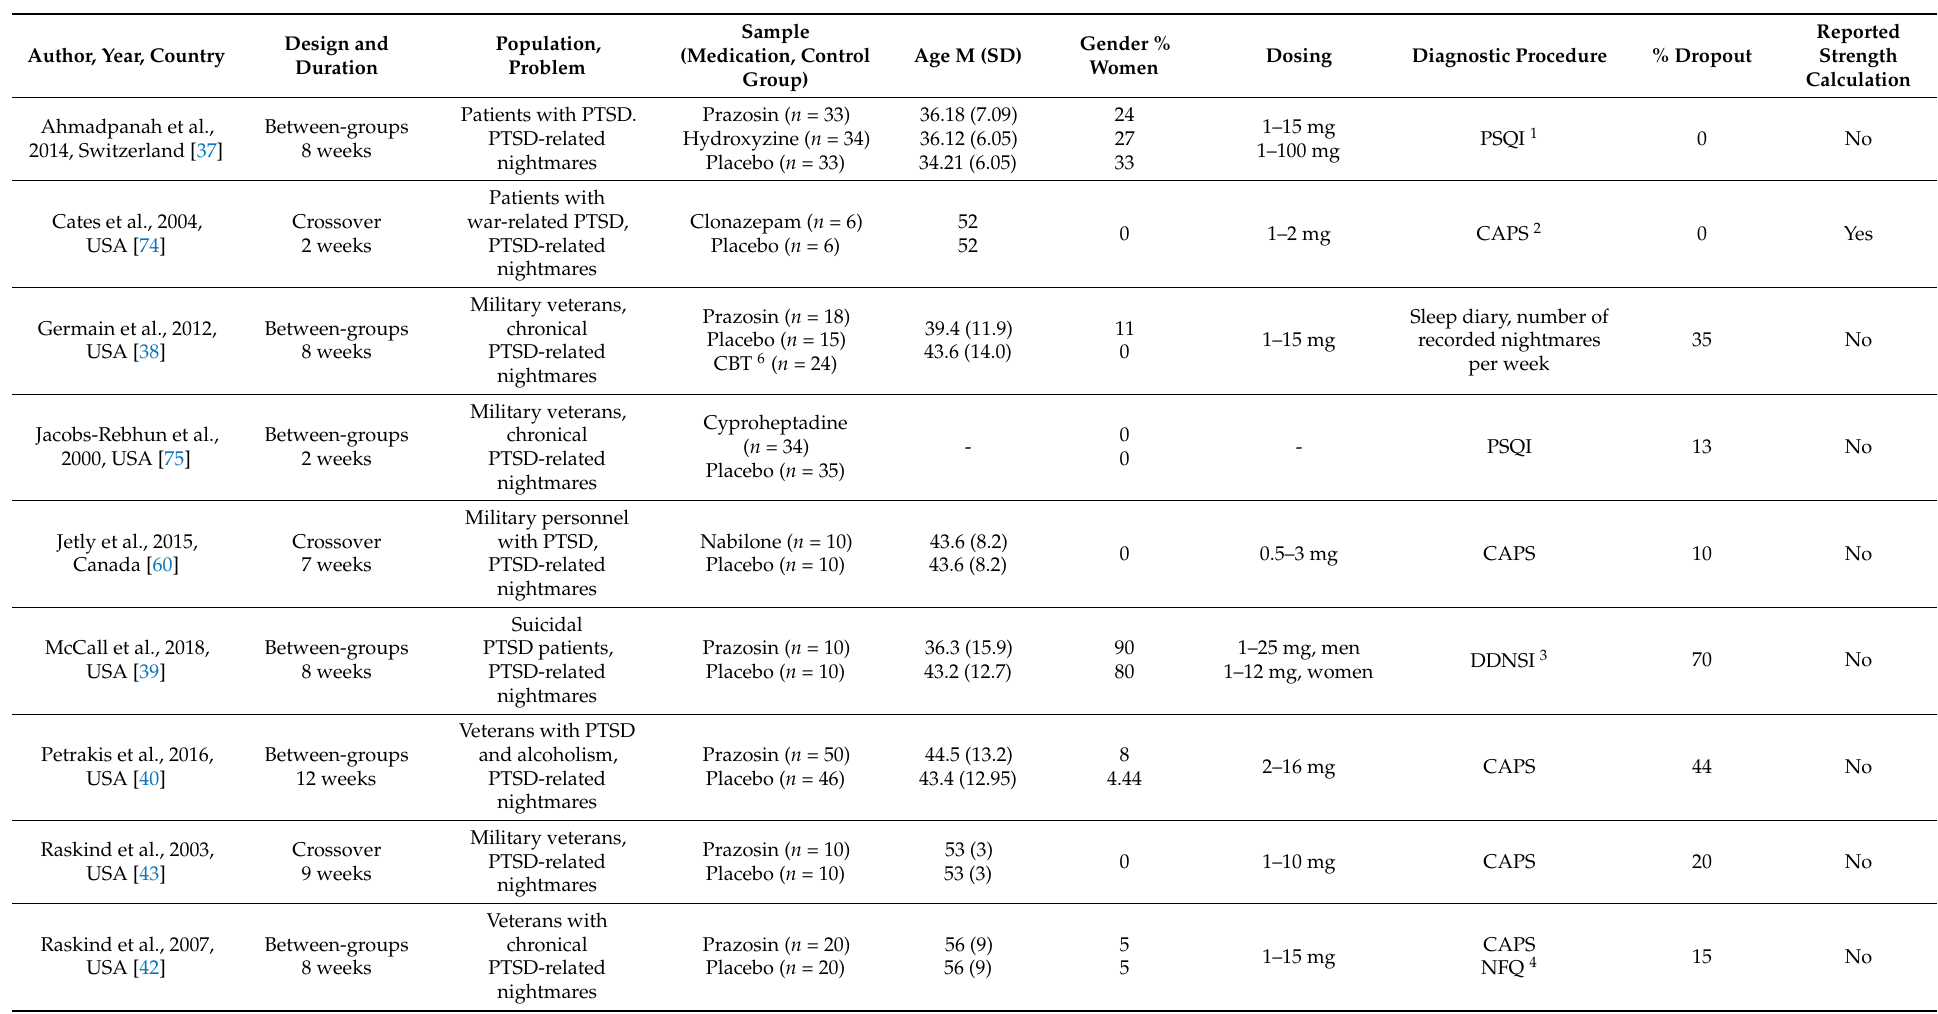
Table 1. Study Characteristics of the Included